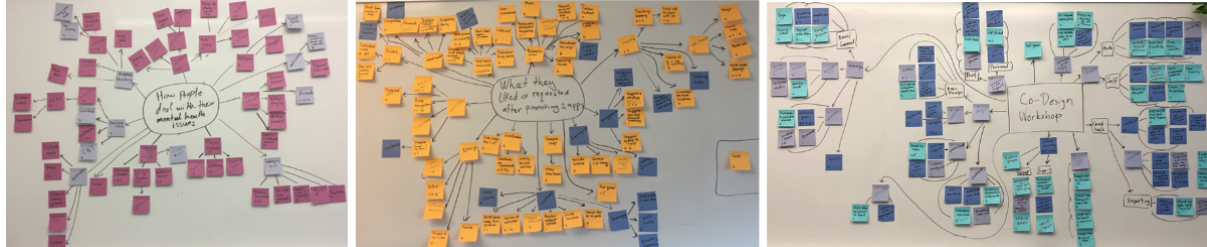
Figure 2. Themes generated from each phase (1, 2, and 3) in order from left to